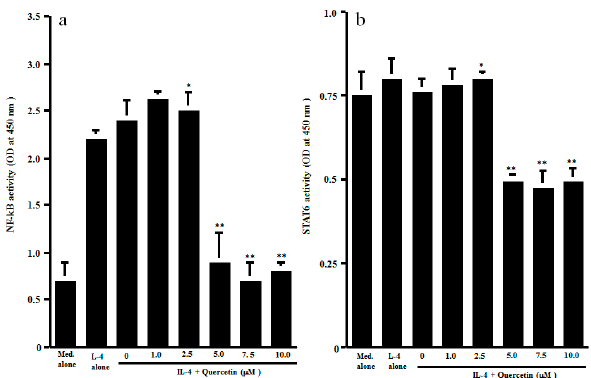
Figure 3. Influence of quercetin on transcription factor activation in CD4 + T cells in vitro. CD4 + T cells (1 × 10 6 cells/mL) were stimulated with 10.0 ng/mL IL-4 in the presence of various concentrations of quercetin for 1 h. Activation of transcription factors NF- κ B ( a ) and STAT6 ( b ) was assessed by ELISA. The results were expressed as the mean OD at 450 nm ± SE of five subjects. * p > 0.05 versus IL-4 alone; ** p < 0.05 versus IL-4 alone. Medicines 2020 , 7 , x FOR PEER REVIEW